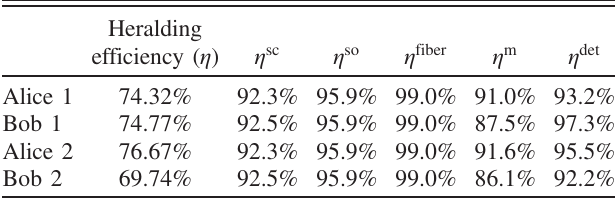
TABLE II. Characterization of optical efficiencies in the experi- ment.